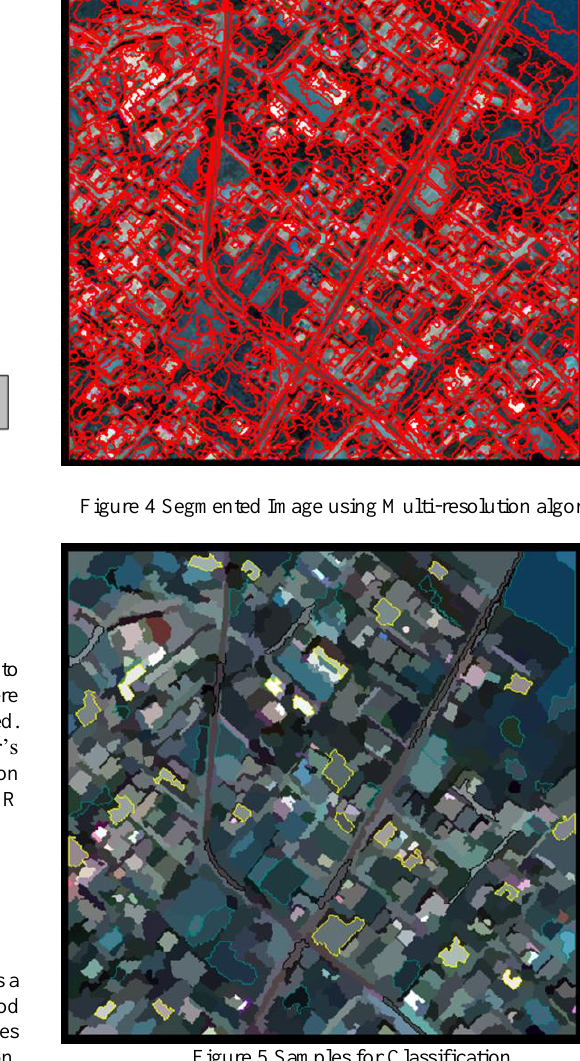
Figure 5 Samples for